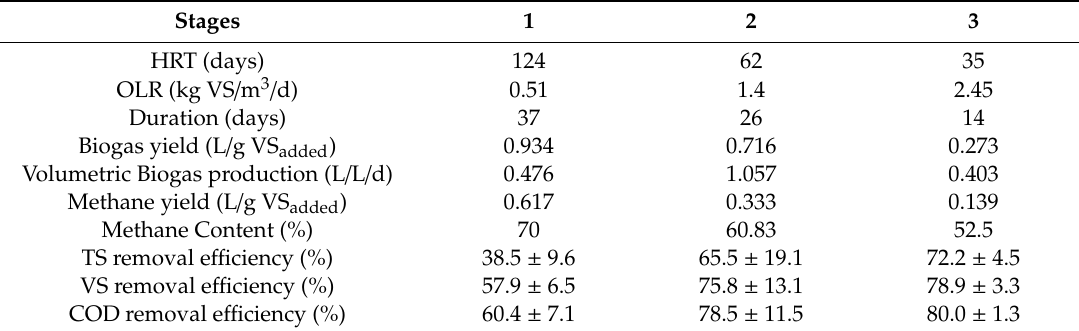
Table 4. Performances of the single-stage